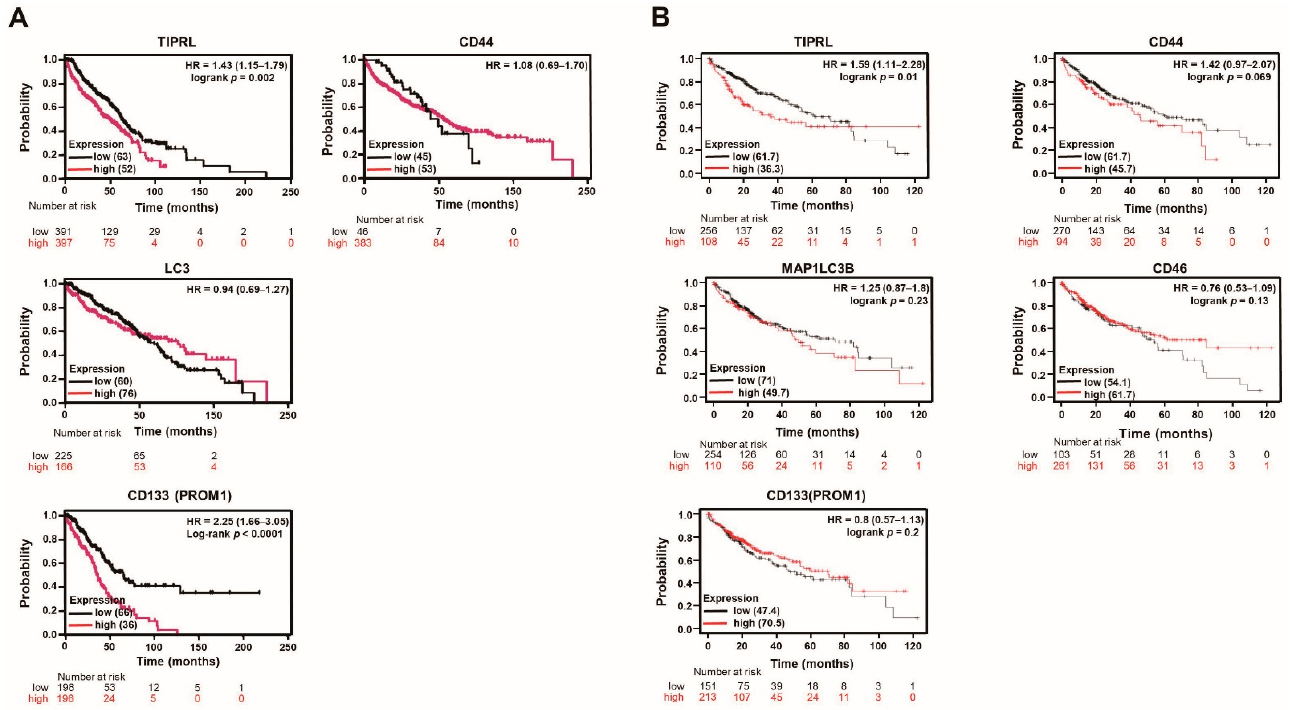
Figure 2. TIPRL predicts the poor prognosis of liver disease patients. ( A ) The survival time of liver disease patients in the training set was calculated using the Kaplan–Meier estimator. HR, (95%CI), Log-rank and p -values are noted. ( B ) A public database (www.kmplot.com accessed on 12–28 January 2021) shows the survivability of liver cancer patients in each variable.